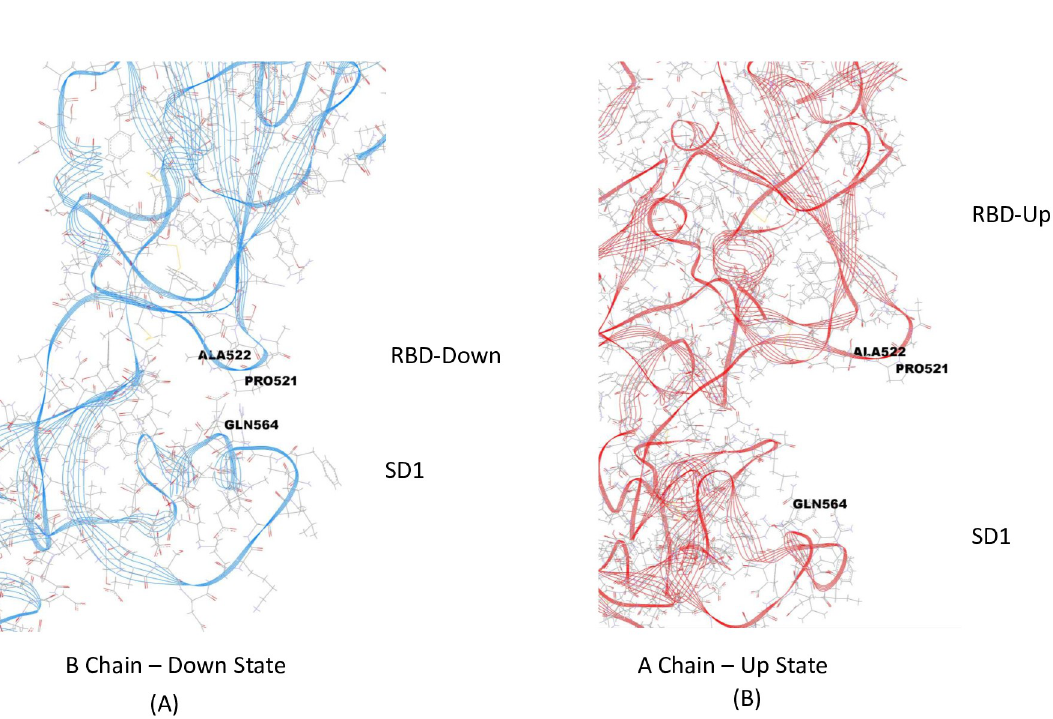
Fig 7. (A) Illustration of the area of dominant energetic interactions between SD1 and RBD of of Chain B Down: GLN564 with ALA520-PRO521-ALA522. (B) On right, the same SD1 area (GLN564) separated from the RBD residues ALA520-PRO521-ALA522.